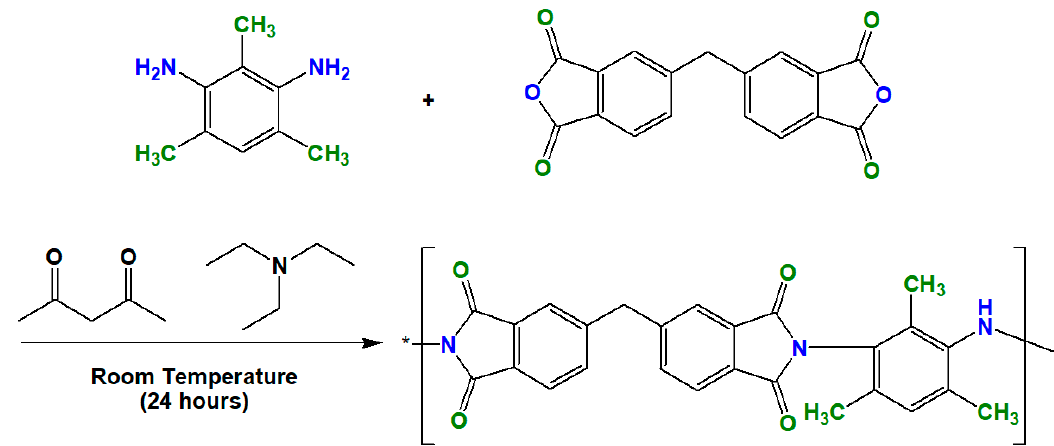
Figure 2. Synthesis of ODPA-TMPDA.